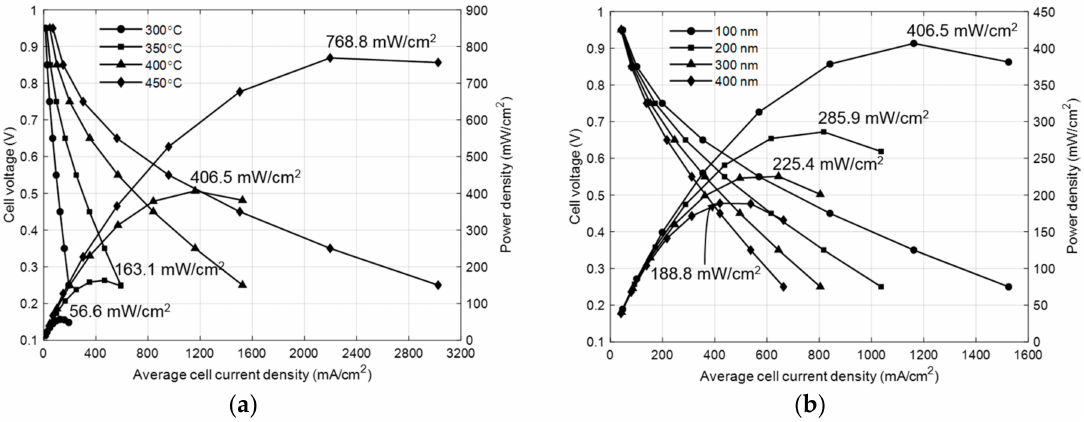
Figure 4. I-V-P curves ( a ) with varying operating temperatures (300, 350, 400, 450 ◦ C); and, ( b ) with varying electrolyte thickness (100, 200, 300, 400 nm) at 400 ◦ C.